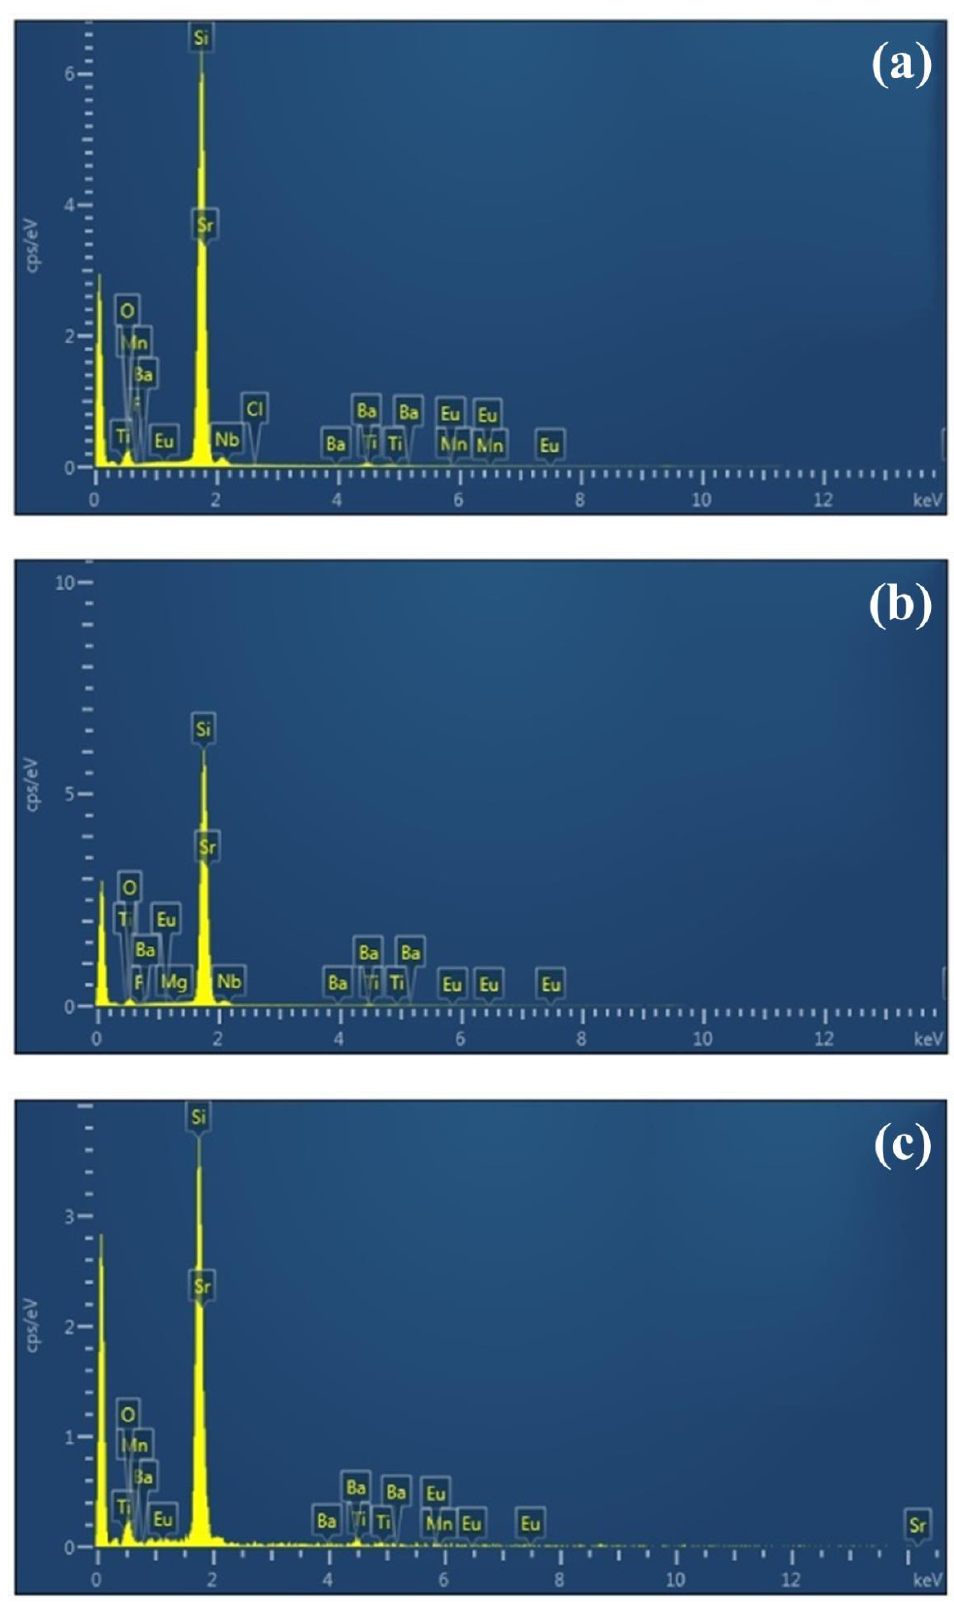
Figure 4. EDS spectra of silicon substrates deposited a SiO 2 layer containing a single phosphor: ( a ) Phosphor-E; ( b ) Phosphor-F; and ( c ) Phosphor-G.